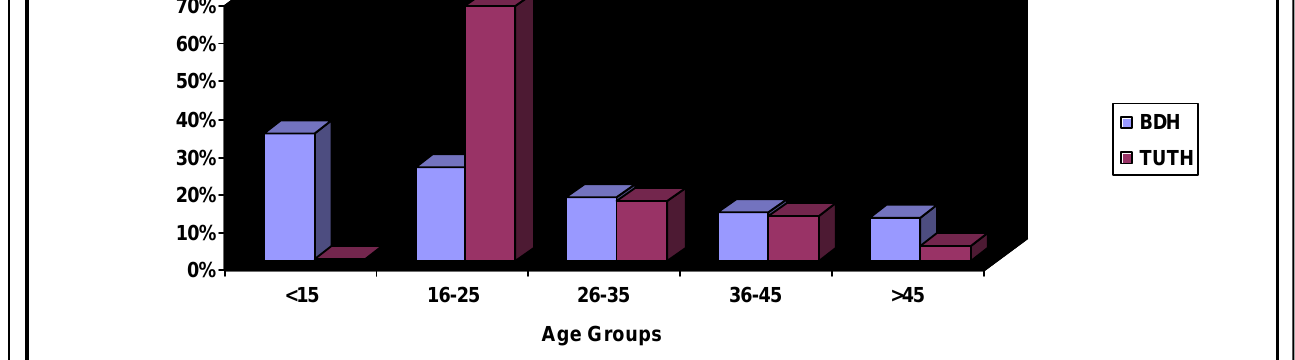
Fig. 1 : Age distribution of the poisoning cases